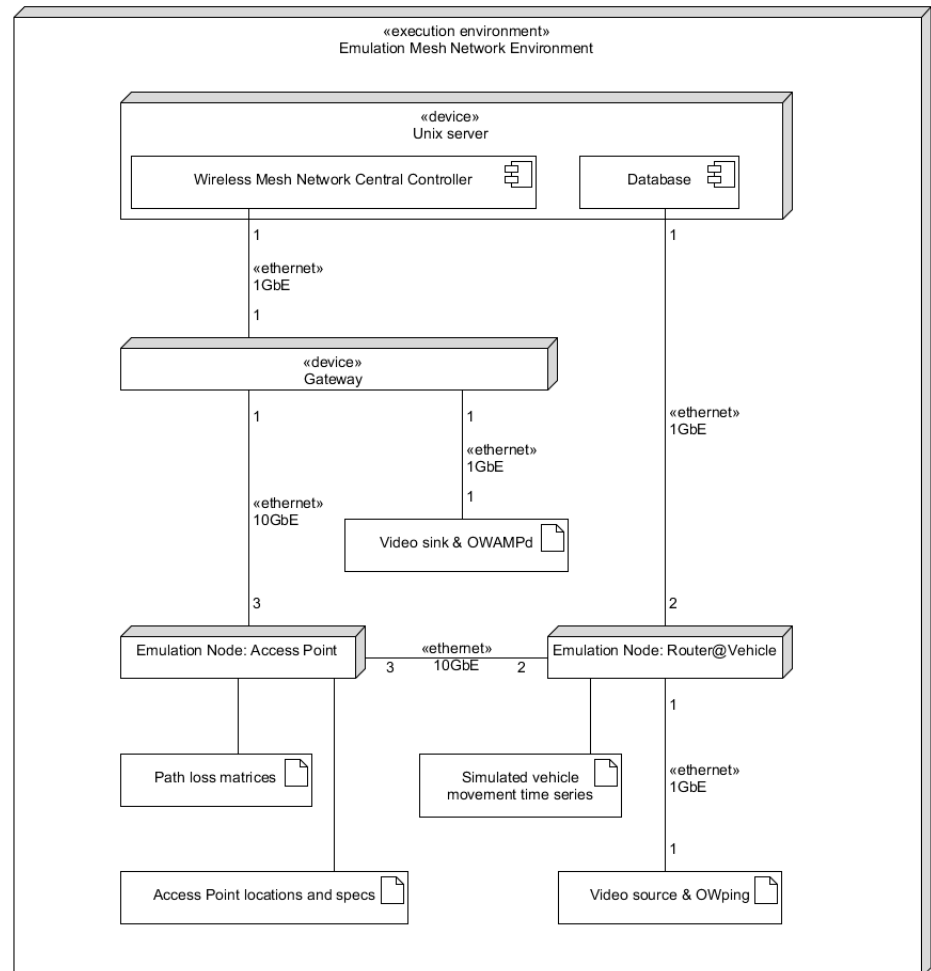
Figure 12. Deployment diagram of emulated mesh network environment.